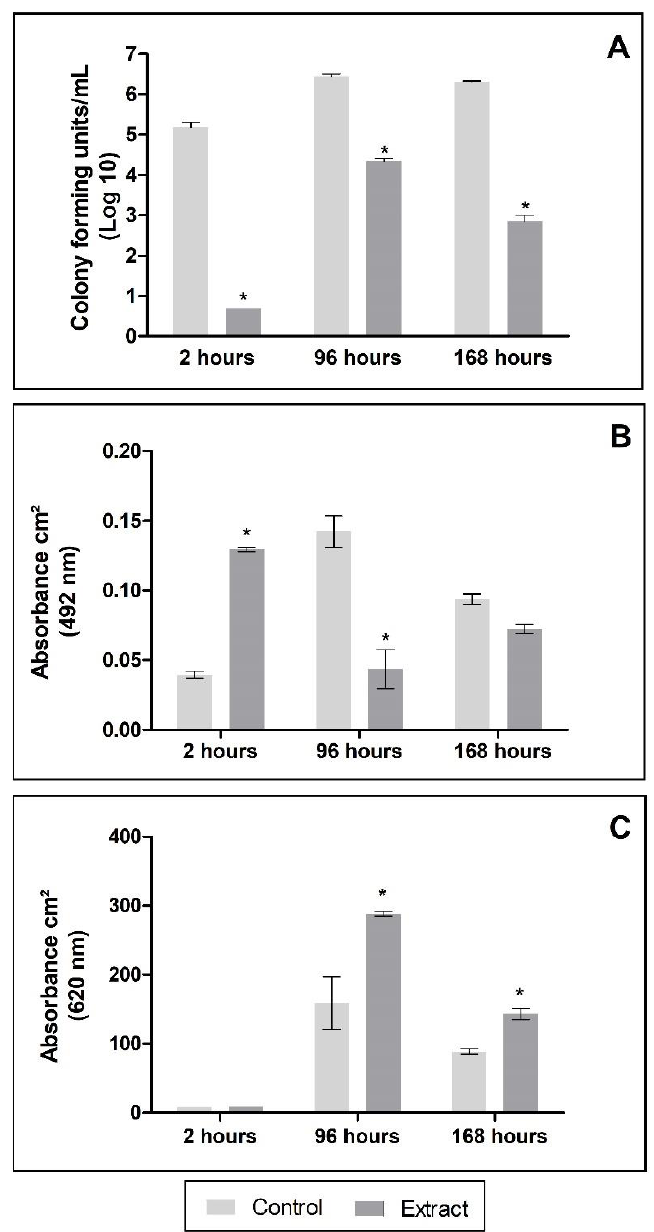
Figure 5. Effects of propolis extract on Neocosmospora keratoplastica biofilm. ( A ) Significant inhibition (*) of the number of cells during the formation of the biofilm and the already formed biofilm ( p < 0.001); ( B ) metabolic activity reduction is statistically significant (*) in biofilms of 96 h ( p < 0.001); ( C ) significant increase (*) in total biomass in 96 h ( p < 0.001); 168h ( p < 0.05).